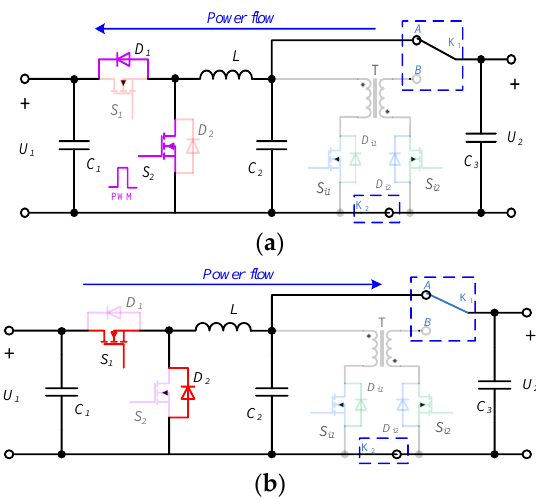
Figure 7. Two operating states of the non-isolated mode: ( a ) forward conversion stage; and ( b ) reverse conversion stage.